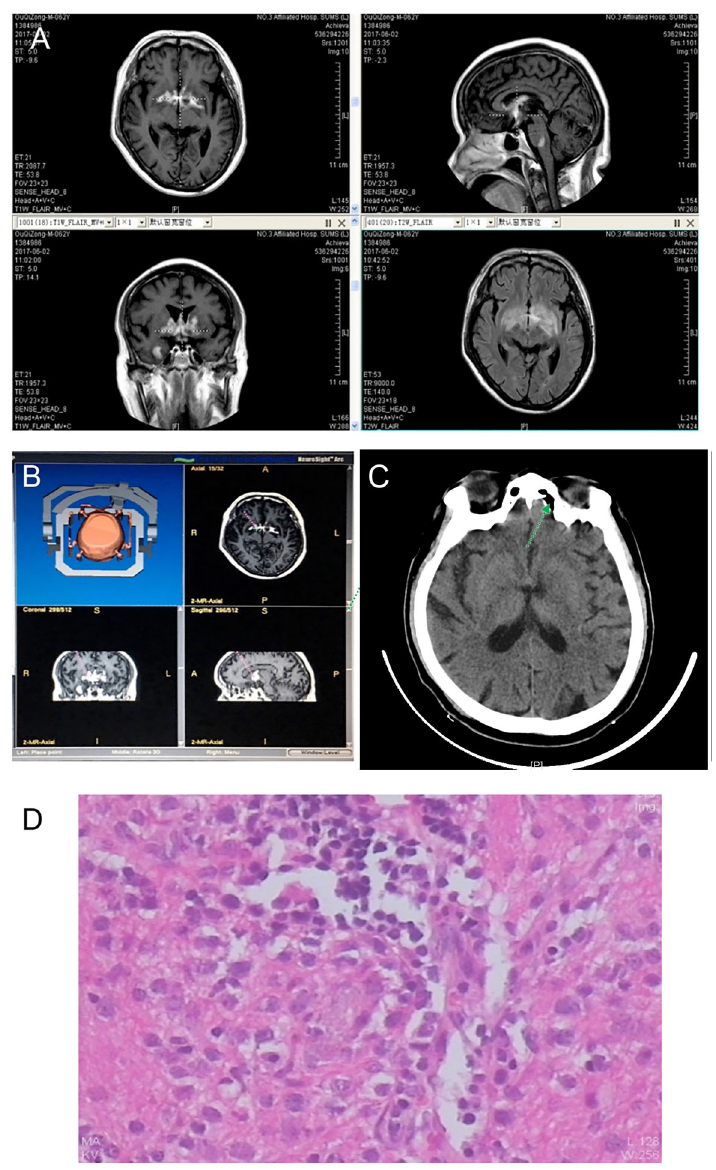
Figure 2. Case 2. A , T1-weighted contrast-enhanced magnetic resonance imaging (MRI) showed a bilateral internal capsule, corpus callosum, and a high-intensity lesion in pons-medulla junction. MRI T2 fl air showed an abnormally high signal. B , Three-dimensional surgical plan – right internal capsule target. C , Computed tomography 1 day after surgery; the arrow shows small areas of pneumocephalus in the genu of the right internal capsule. D , Pathological diagnosis of diffuse large B-cell